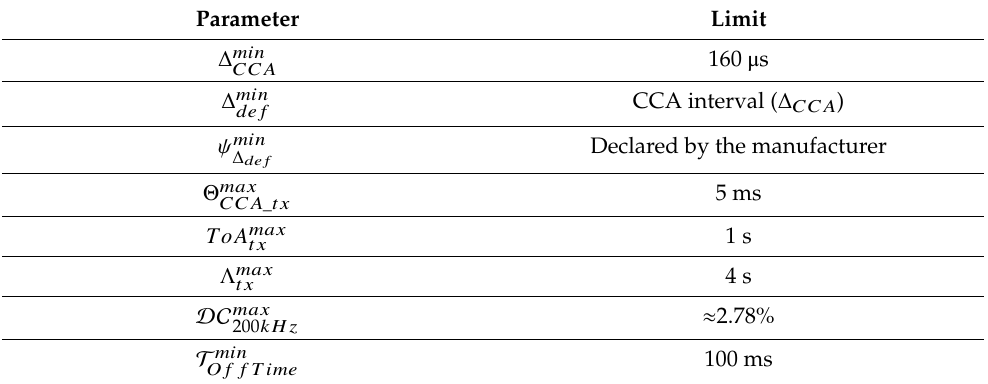
Table 2. Timing parameters of polite medium access based on LBT